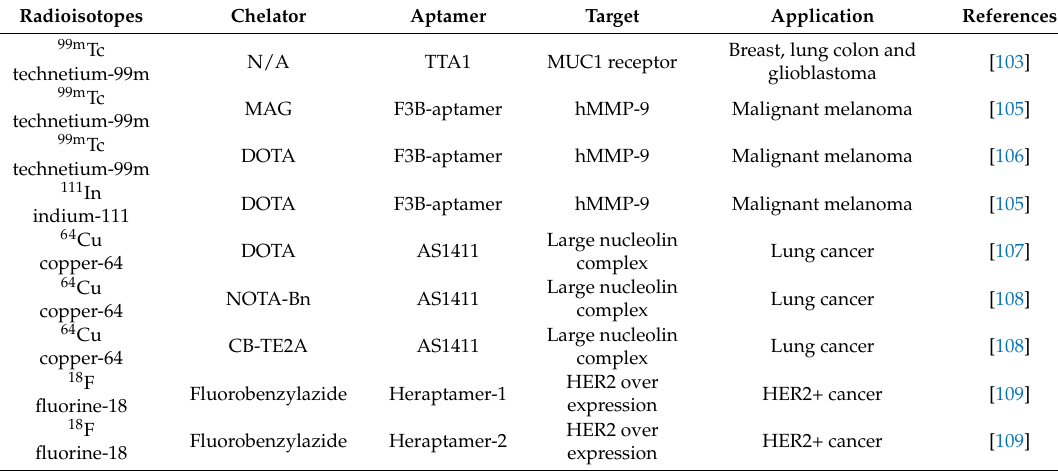
Table 3. Examples of radiolabelled